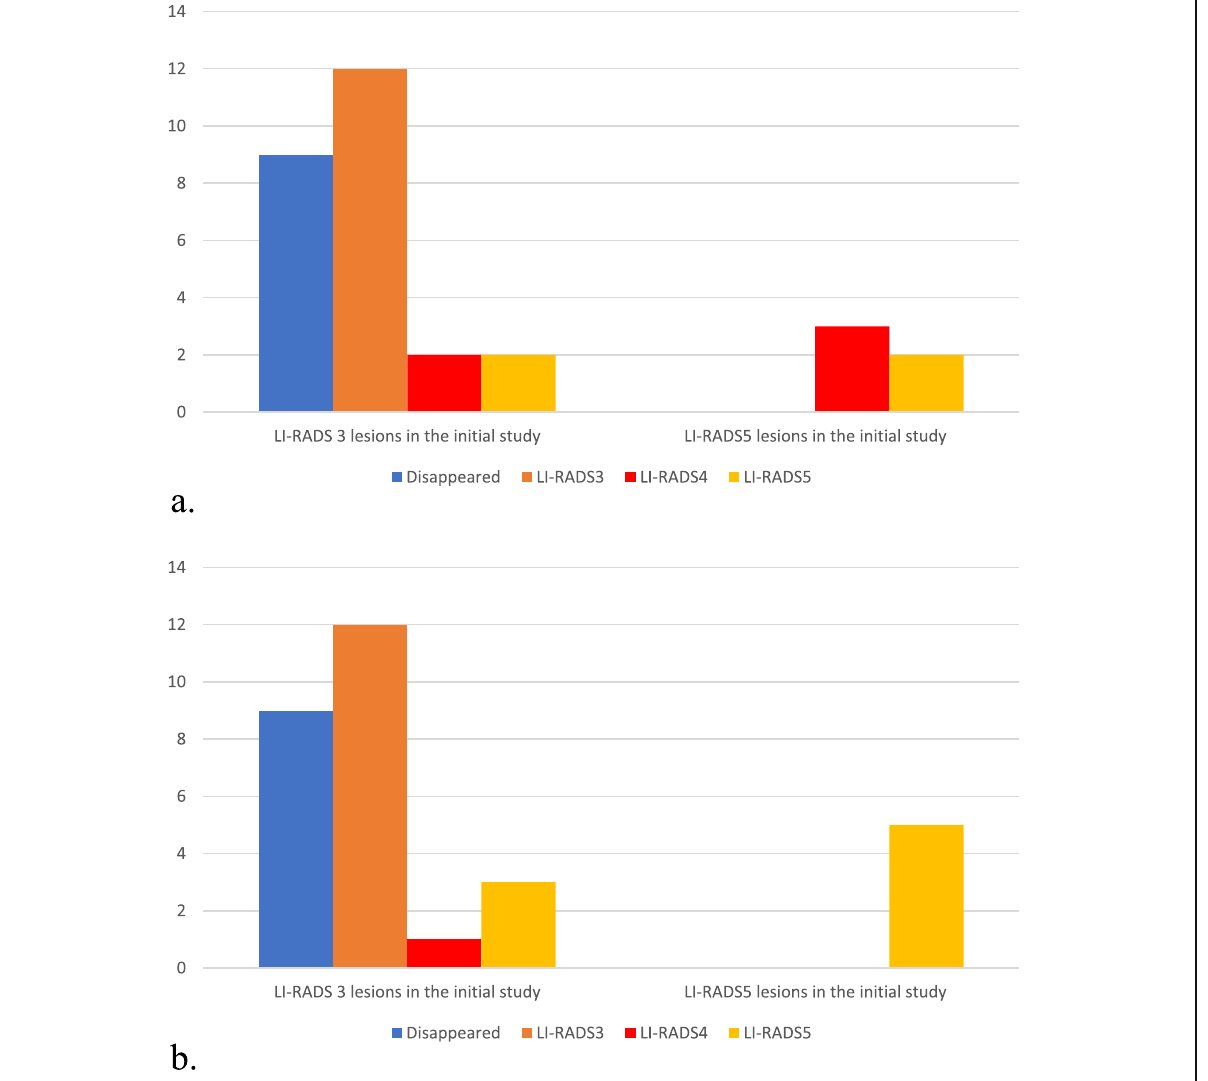
Fig. 3 LIRADS classification of the lesions in the follow-up study using LIRADS version 17 ( a ) and version 18 ( b